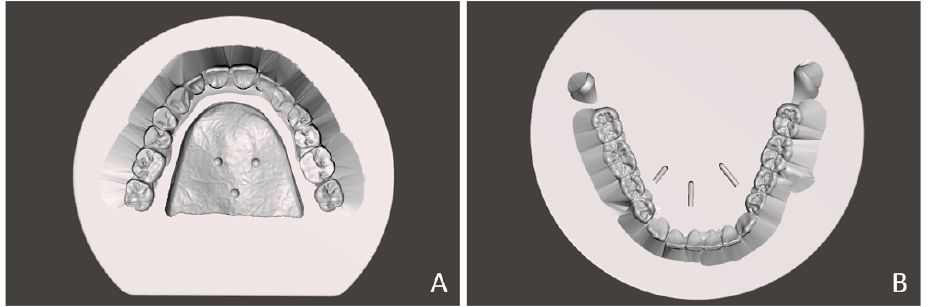
Figure 3. Design of the geometry guides. ( A ) Maxillary geometry guide. ( B ) Mandibular geometry guide.